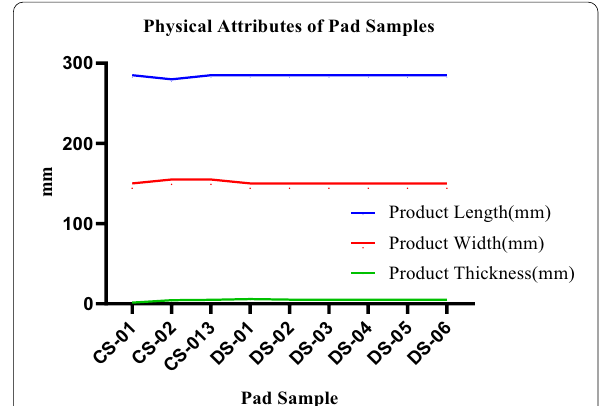
Fig. 12 Physical attributes of various pad